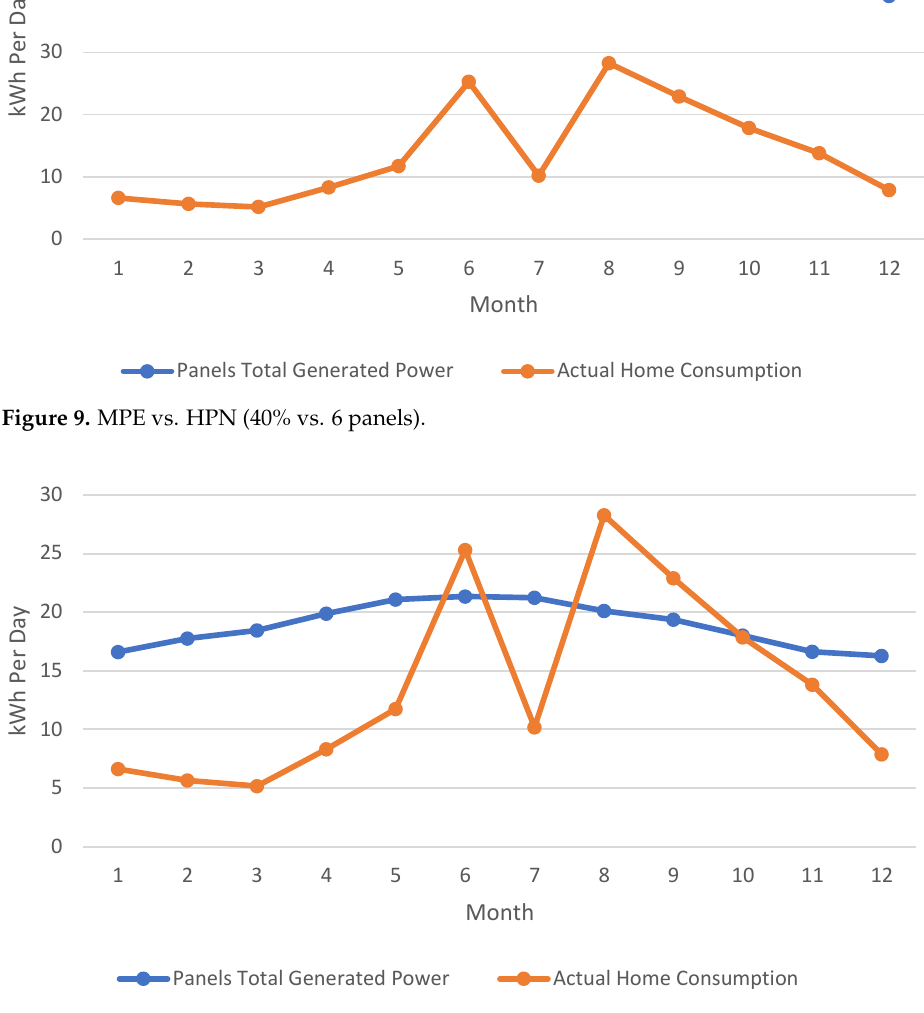
Figure 9. MPE vs. HPN (40% vs. 6 panels) .